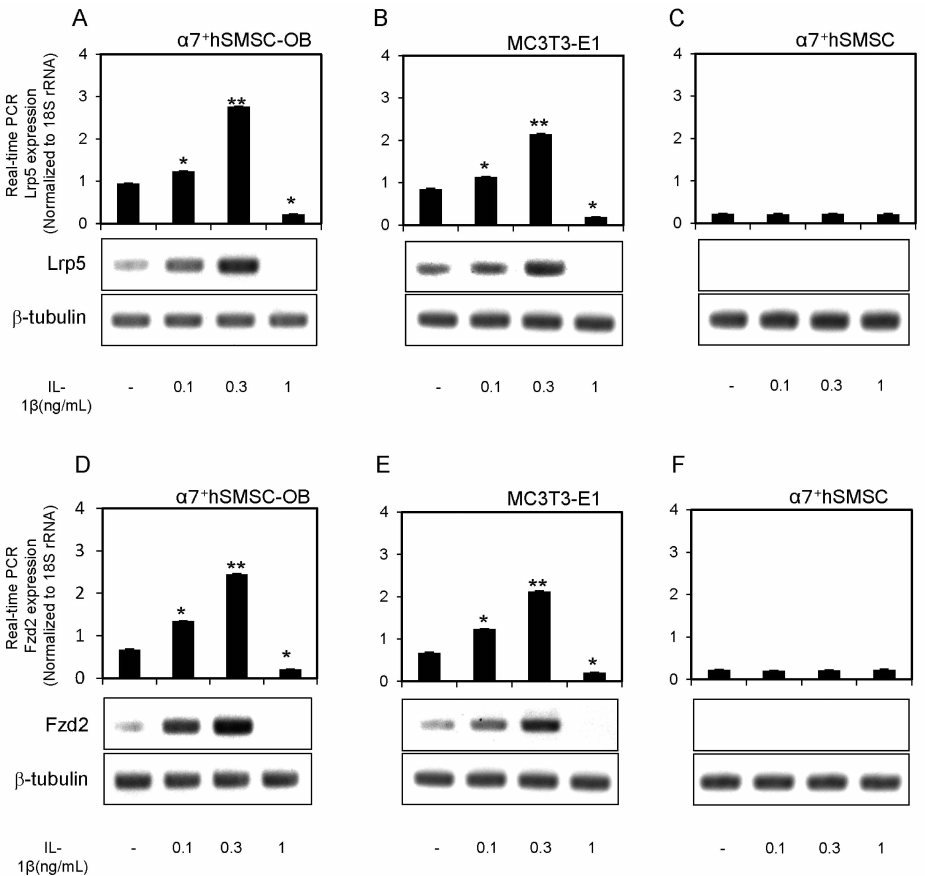
Figure 2. Expression of Lrp5 and Fzd2 mRNAs and proteins in α 7 + hSMSC-OB cells, MC3T3-E1 cells, and α 7 + hSMSCs. ( A – F ) Cells were stimulated with IL-1 β (0, 0.1, 0.3 and 1 ng/mL) prior to real-time qPCR analysis of Lrp5 and Fzd2 expression relative to the control (18S rRNA). Data are the mean ˘ SD of four independent experiments. * p < 0.05, ** p < 0.01. Lower panels show Western blot analysis of Lrp5, Fzd2, and β -tubulin protein levels following stimulation with IL-1 β . Blots are representative of three independent